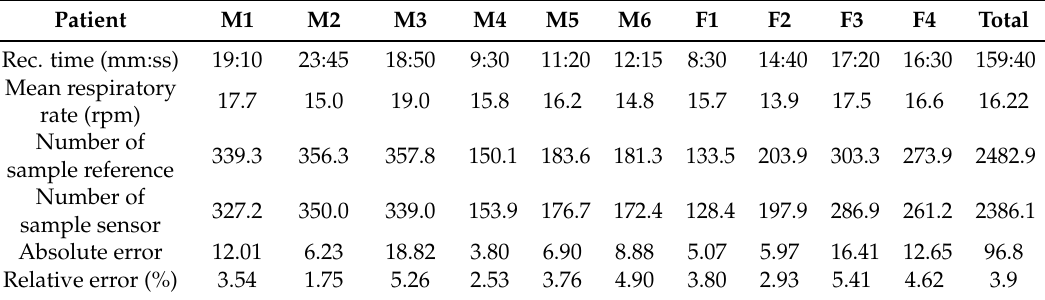
Table 2. Summary of the experimental results of respiratory